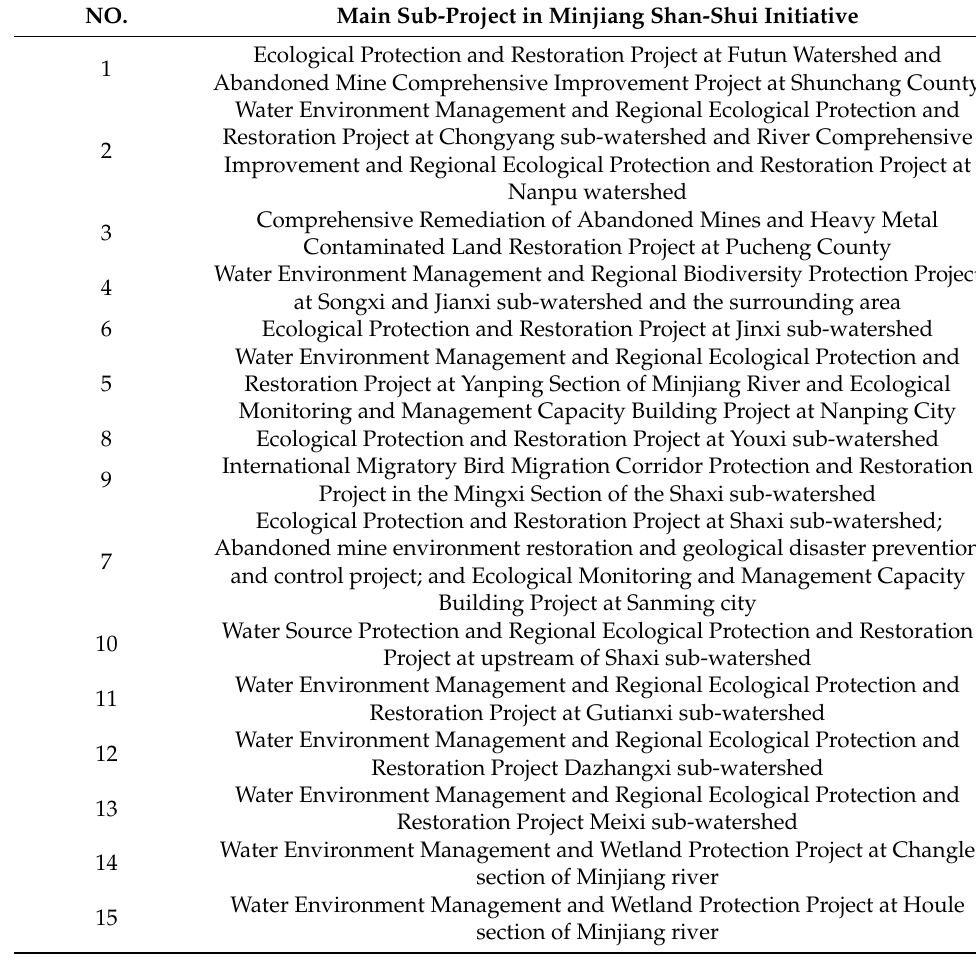
Table 1. The 15 Main Sub-projects in Minjiang Shan-Shui Initiative.